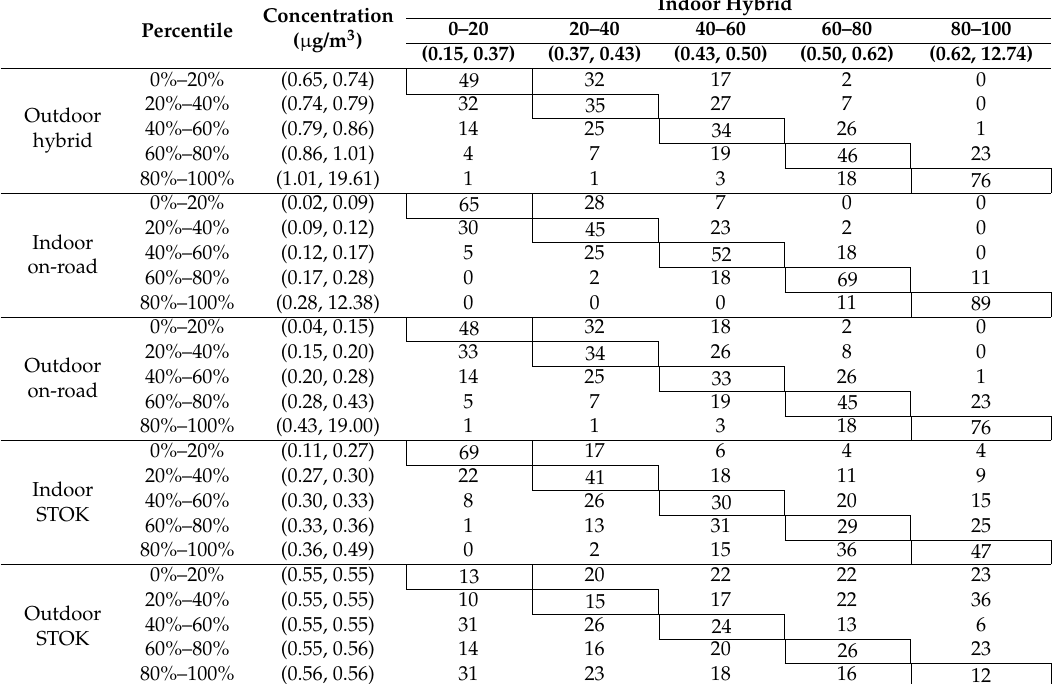
Table 6. Contingency table for EC showing agreement between exposure quintiles. The values represent percentage of Census blocks in each quintile. Concentration ranges are shown in parentheses. Boxed percentages along diagonals would be 100% for a perfect